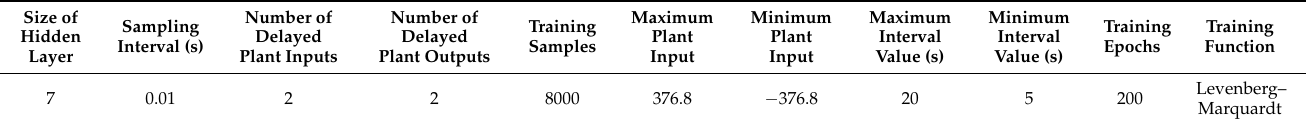
Table 3. The parameters of plant identification.